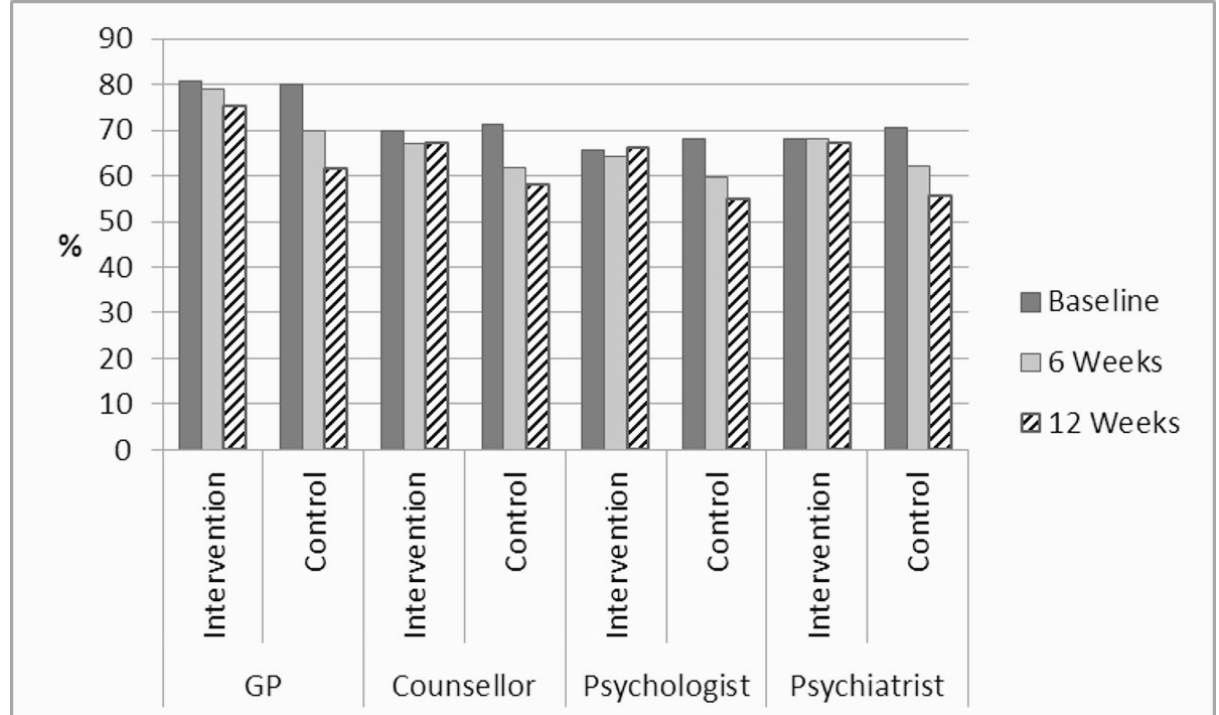
Figure 4. Comparisons between online self-help and face-to-face professional